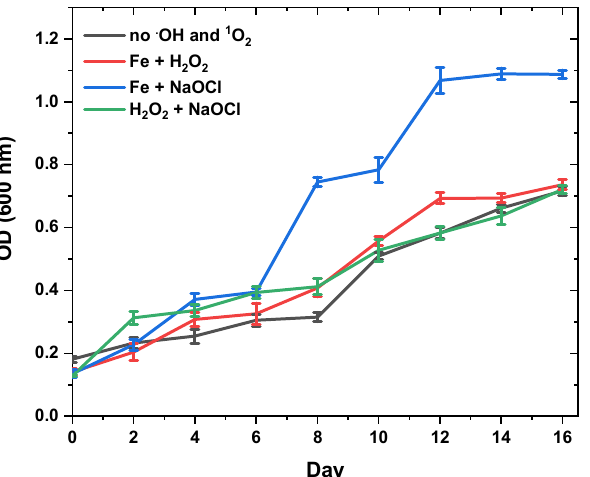
Figure 3. Plot showing the effect of various oxidative stress conditions on the optical density of N. shiloi . Reported results are the average of three replicates (i.e., n = 3), with error bars denoting one standard deviation about the mean.